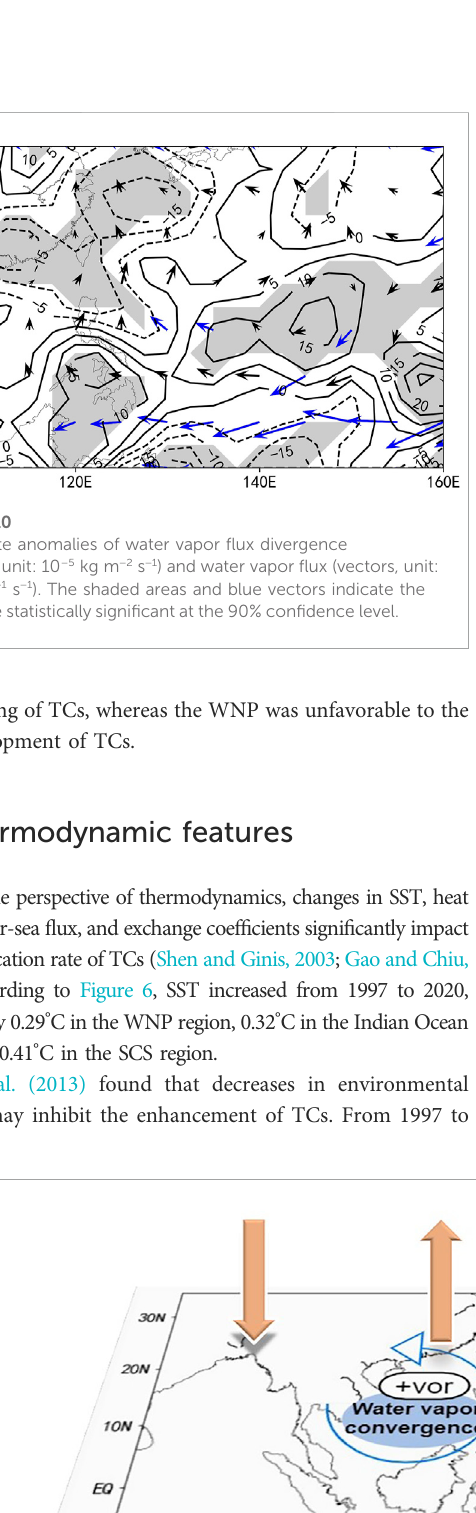
Physical mechanism diagram of interannual variation of TC frequency reaching LMI in the SCS. White arrows indicate wind, blue arrows circles indicatecycloniccirculation(oranticycloniccirculation),greenareaindicatepositiveverticalwindshearanomalies,andorangearrowsindicatezonal circulation anomalies from 10 ° N to 25 ° N. The blue and orange areas indicate water vapor convergence and divergence areas. The white area indicates positive relative